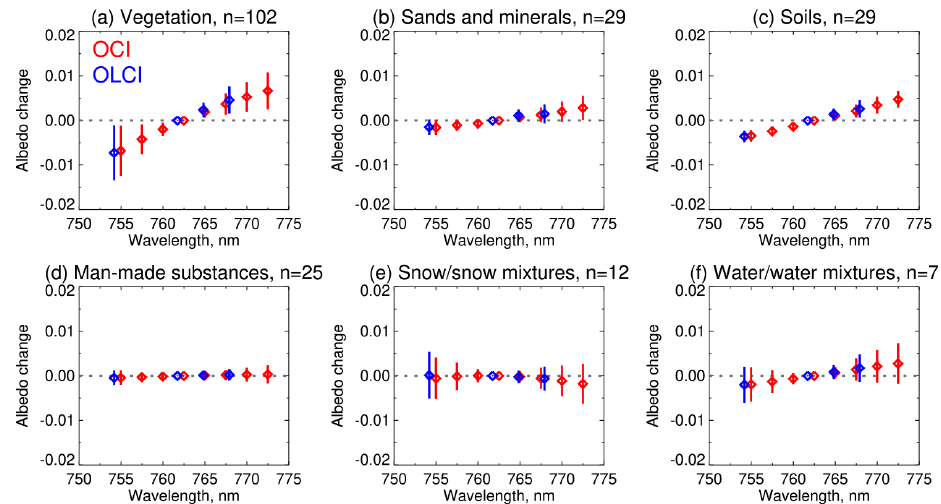
Figure 6. Spectral slope of surface albedo across the A-band for (red) OCI and (blue) OLCI, expressed as differences relative to the albedo at the sensor channel of maximum absorption. Points and lines show the mean and standard deviation of spectral differences in each category. Panels show (a) vegetation, (b) sands and minerals, (c) soils, (d) man-made substances, (e) snow and snow mixtures, and (f) water and water mixtures. The number of spectra in each category is given in each panel’s